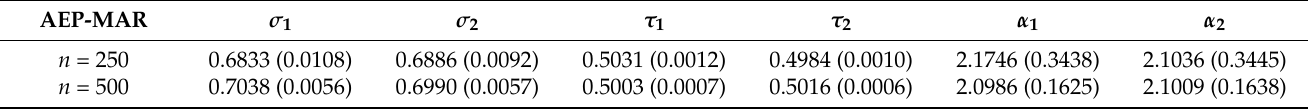
Table 2. Simulation results of AEP-MAR for Scenario 1 .